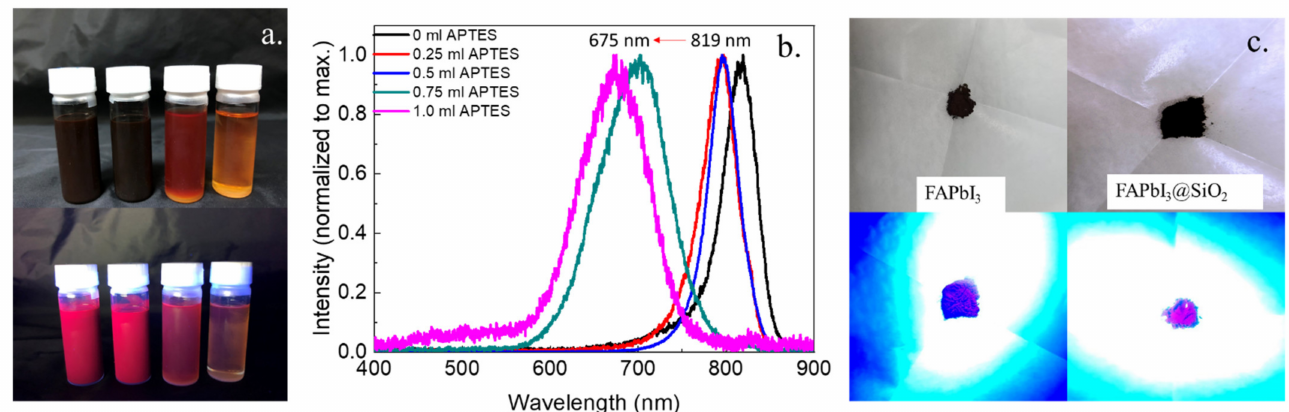
Figure 5. ( a ) Photographs of FAPbI 3 NCs solvent (from left to right: 0.25–1.0 mL of APTES) under room light and the UV light respectively; ( b ) the PL spectra of FAPbI 3 NCs with different amount of APTES, and ( c ) photographs of FAPbI 3 and FAPbI 3 NCs powders under room light and UV